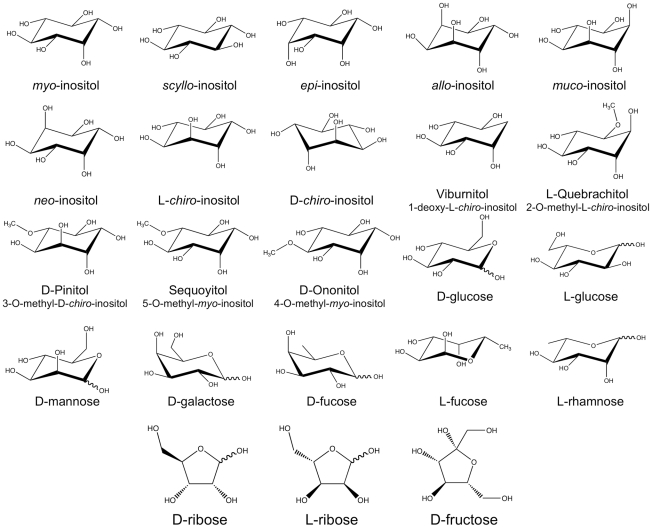
Structures of the inositol stereoisomers, derivatives and related compounds.The structures of the inositol stereoisomers, derivatives and related compounds used for the initial competitive transport assays.